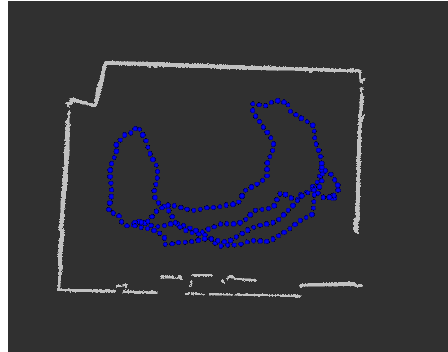
Figure 12. Room Segmentation Process in Scenario 1. Trajectory points in blue, detected doors in red.